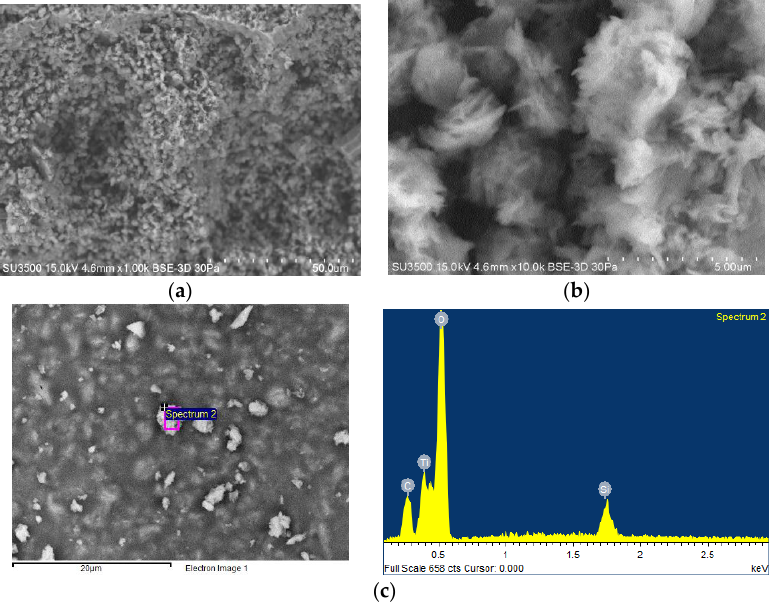
Figure 4. ( a , b ) Scanning electron microscopy (SEM) morphology of the Ti–O–Si-organic precursor; ( c ) Energy Dispersive Spectrometer (EDS) elemental analysis.